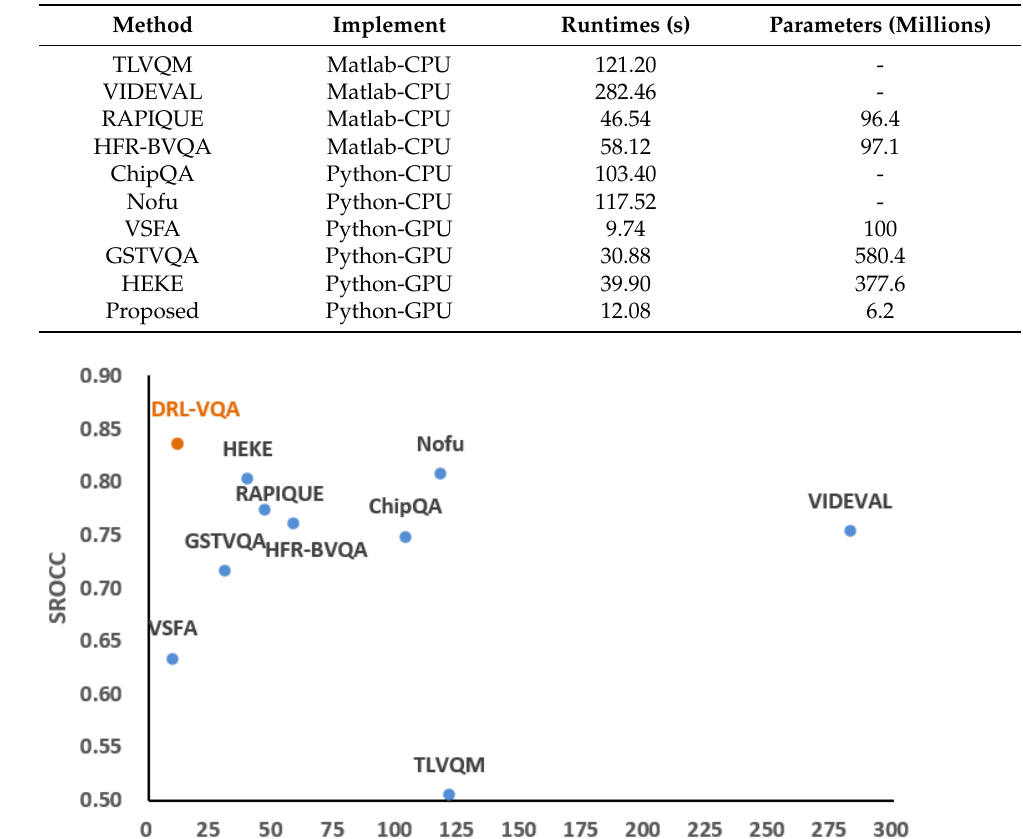
Table 3. Performance on computation complexity.